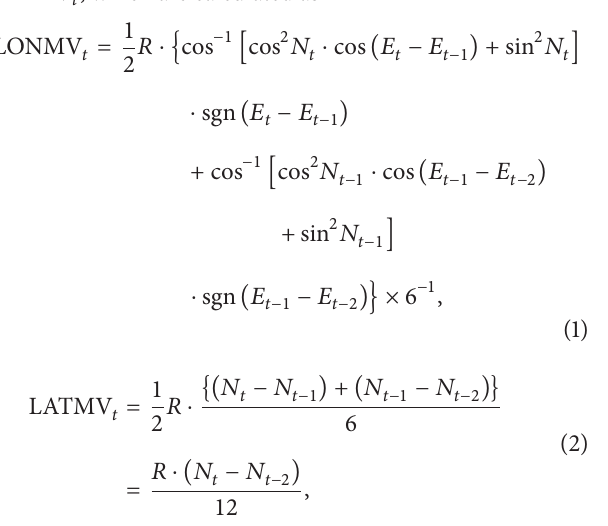
Figure 2: The monthly statistical result.